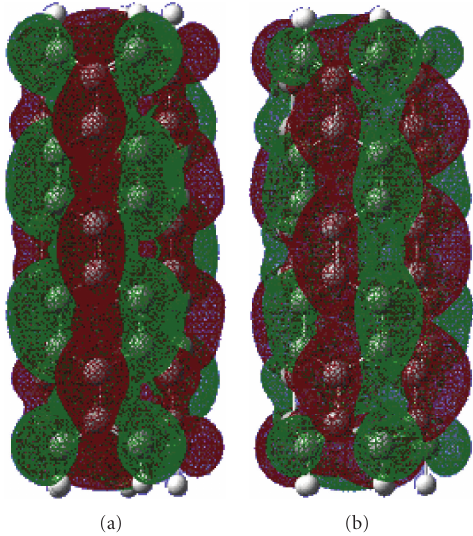
Figure 7: Spatial distribution of the LUMO orbitals for (a) the C 60 H 20 nanotube and (b) the nanotube radical with a missing H atom from the tip C 60 H 19 . The wave function isosurfaces of values +0.01 and − 0.01 (e/ ˚A 3 ) 1 / 2 are shown in red and green,